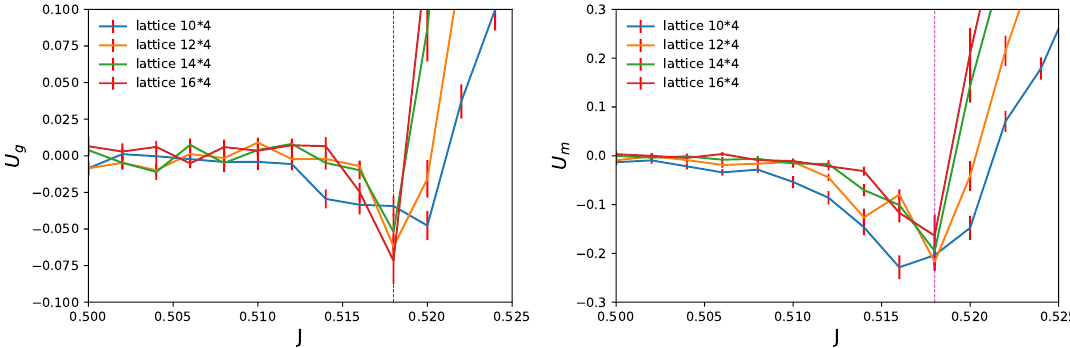
Figure 6 . The Binder cumulant for the gauge field order parameter (lhs.) and the matter order parameter (rhs.). For different volumes we show the results at β = β ∗ as a function of J and zoom into the region near the first order transition point at J 1 ∼ 0 . 52